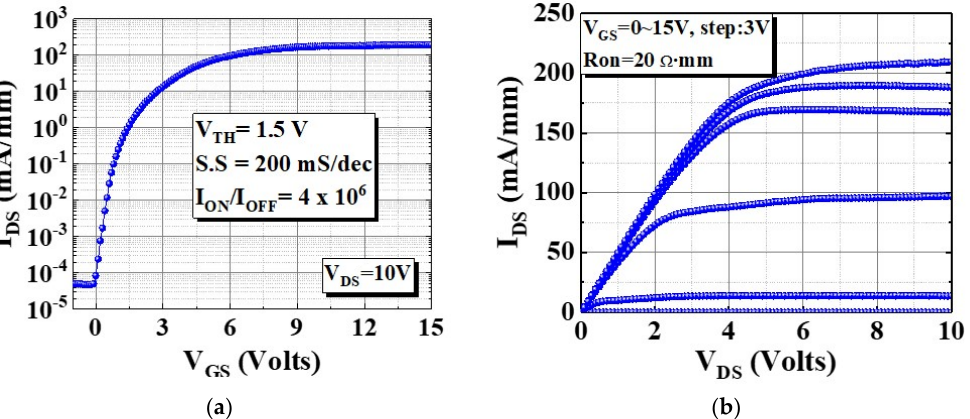
Figure 2. Device’s dc characteristics with L GS , L G , L GD , and W G = 2, 5, 10, and 100 μ m, respectively: ( a ) transfer and ( b ) output characteristics.